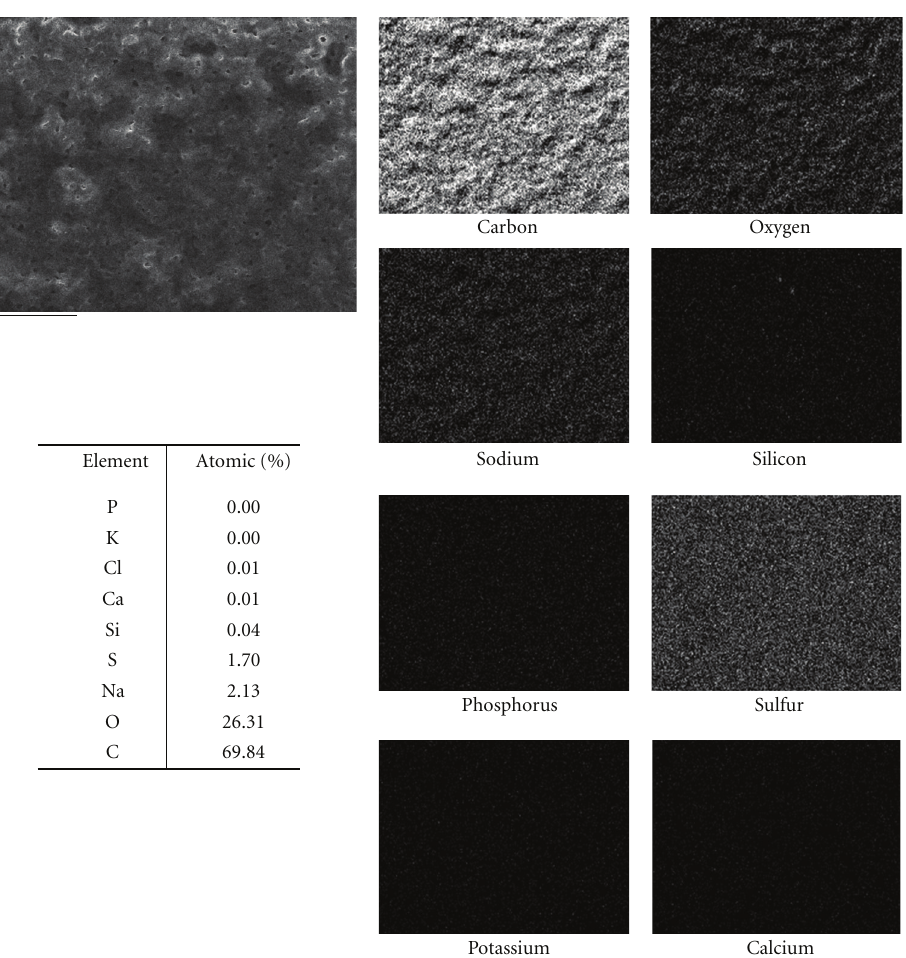
Figure 9: X-ray EDS mapping and relative atomic composition for a Sicopion 35% SFSP membrane. Bar under SEM is 100 µ